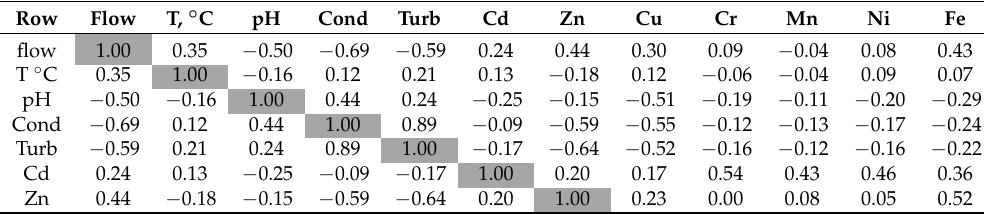
Table 2. Correlation matrix.